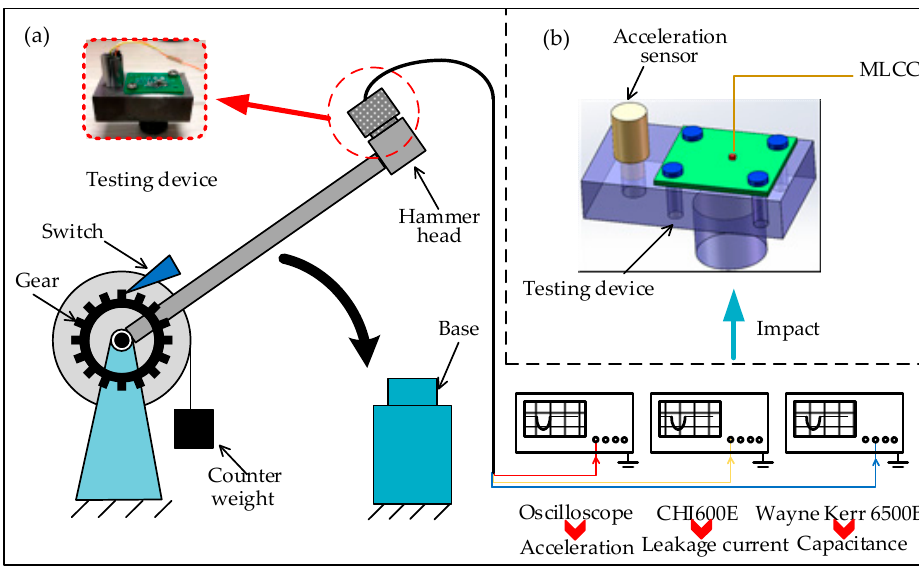
Figure 2. Experimental system diagram: ( a ) schematic diagram of a Machete hammer test system; ( b ) installation diagram of the capacitance and sensor.